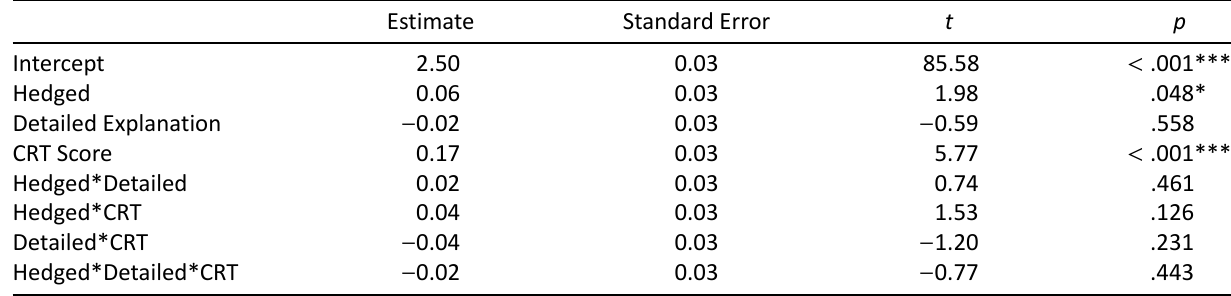
Table 4. General linear model predicting acceptance of information from correction style conditions and CRT as potential moderator.